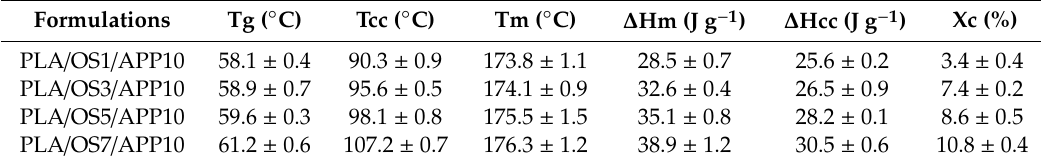
Table 5. Thermal properties of fibers by DSC